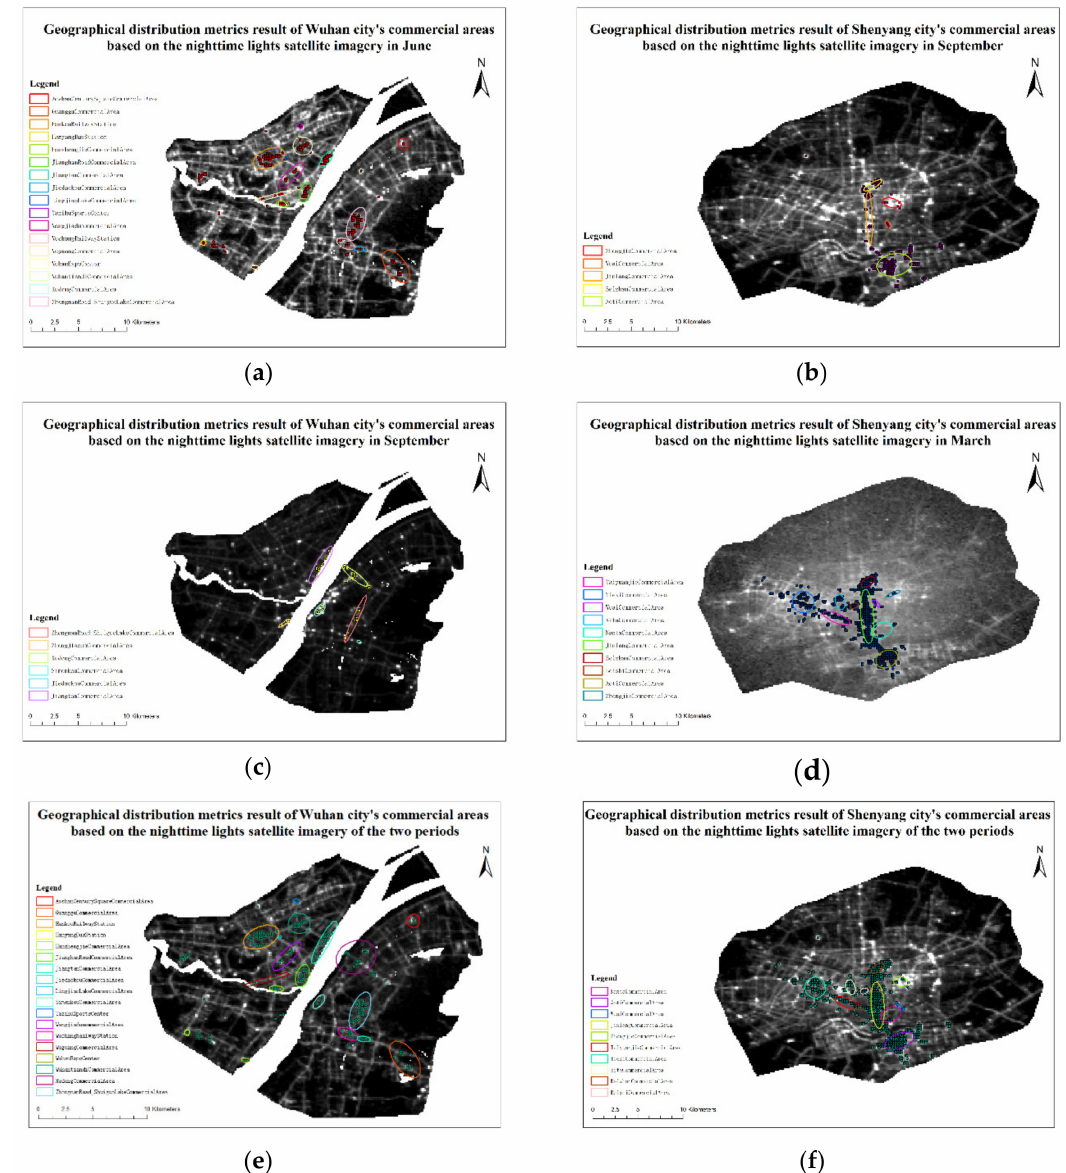
Figure 8. Geographical distribution metrics results: ( a ) results of detection in Wuhan on 14 June 2018; ( b ) results of detection in Shenyang on 10 September 2018; ( c ) results of detection in Wuhan on 15 September 2018; ( d ) results of detection in Wuhan on 17 March 2019; ( e ) results of the combination of ( a ) and ( c ); and ( f ) results of the combination of ( b ) and ( d